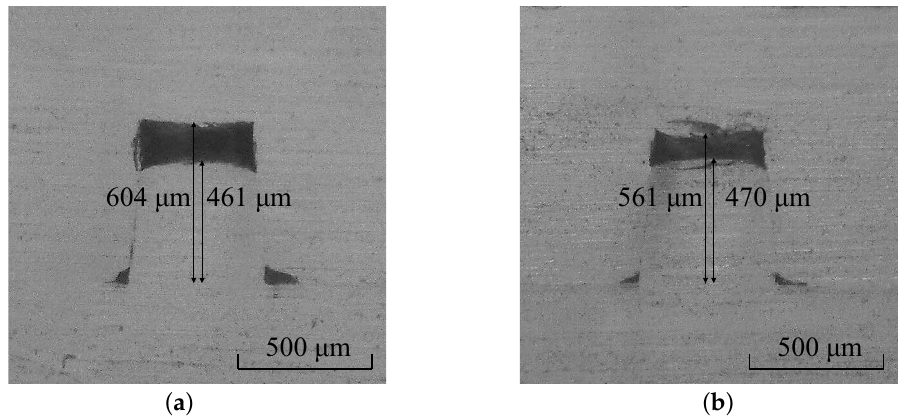
Figure 8. Cross-sectional micrographs of the microchannels bonded at temperatures of ( a ) 97 ◦ C; and ( b ) 100 ◦ C. The bonding pressure corresponds to 2